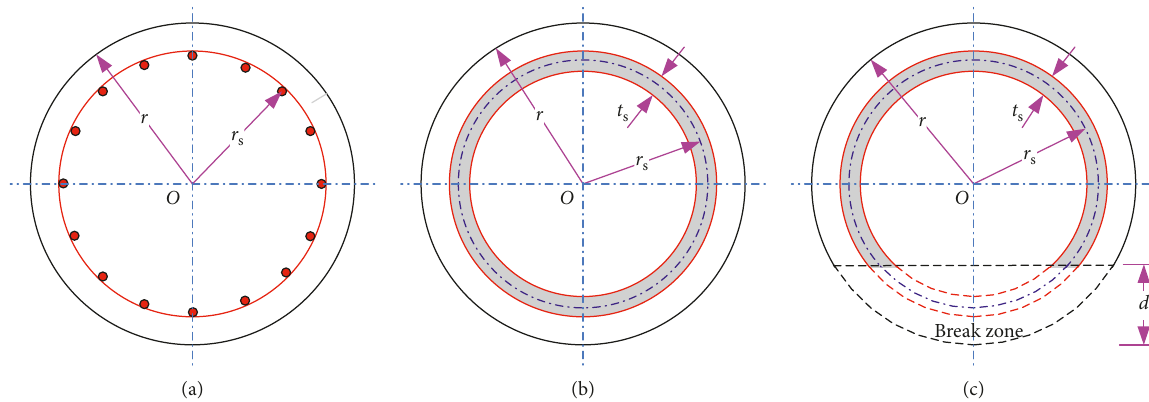
Figure 4: Equivalent transformation of circular section retaining pile bars into steel ring. (a) Initial cross section. (b) Equivalent cross section. (c) Cross section with pile excision.